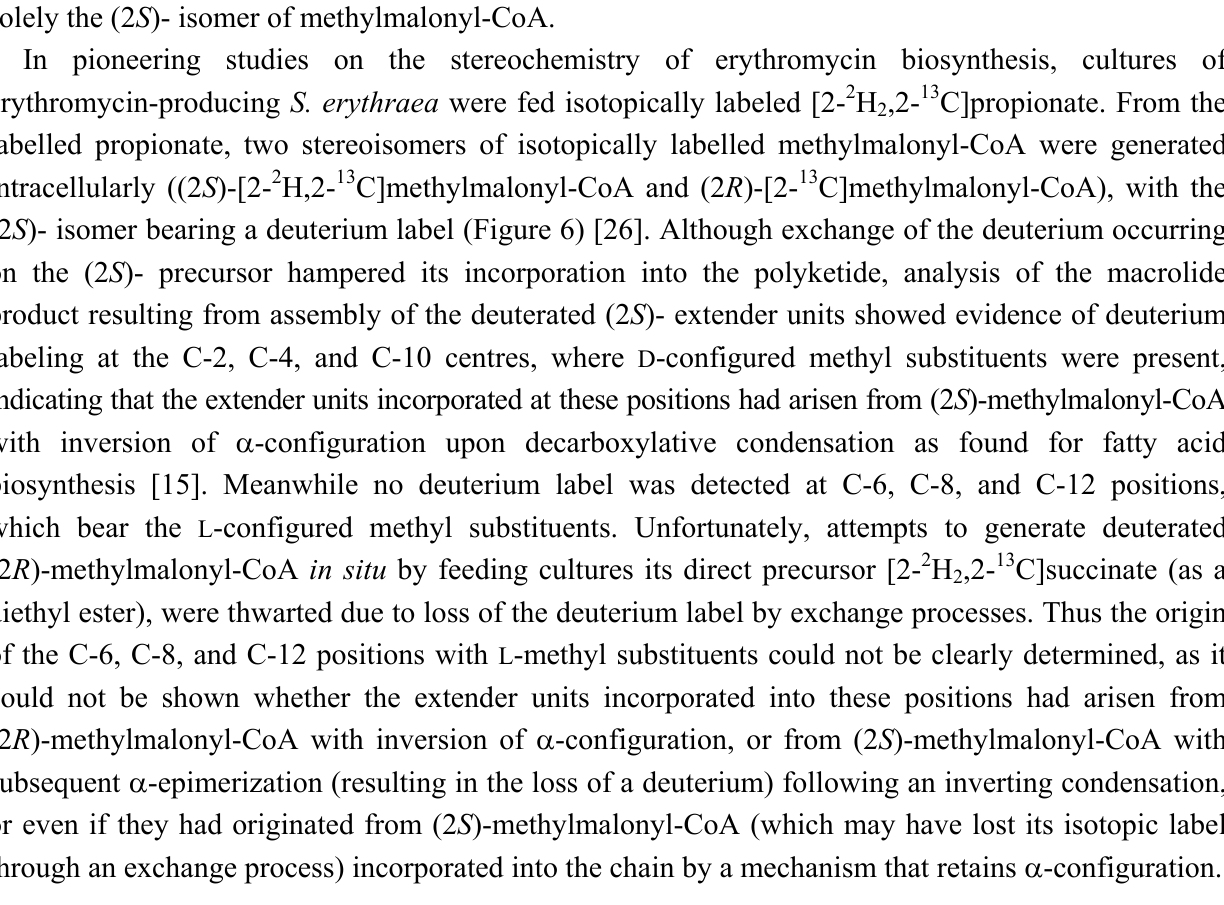
Figure 6. Feeding of labeled precursor, [2- 2 H